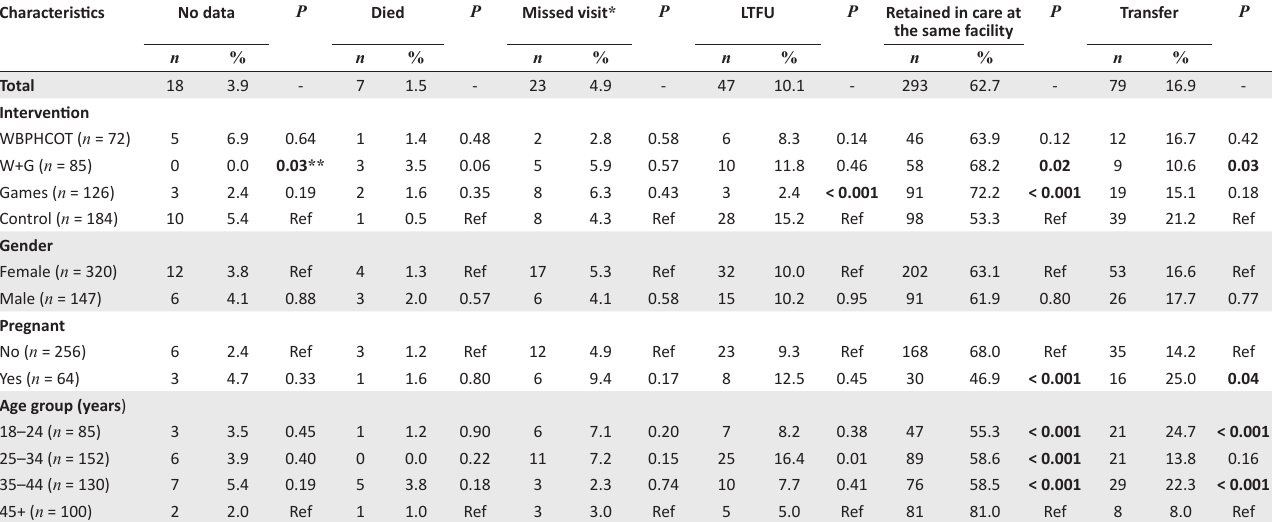
TABLE 2: Participant outcomes at 12 months. Characteristics